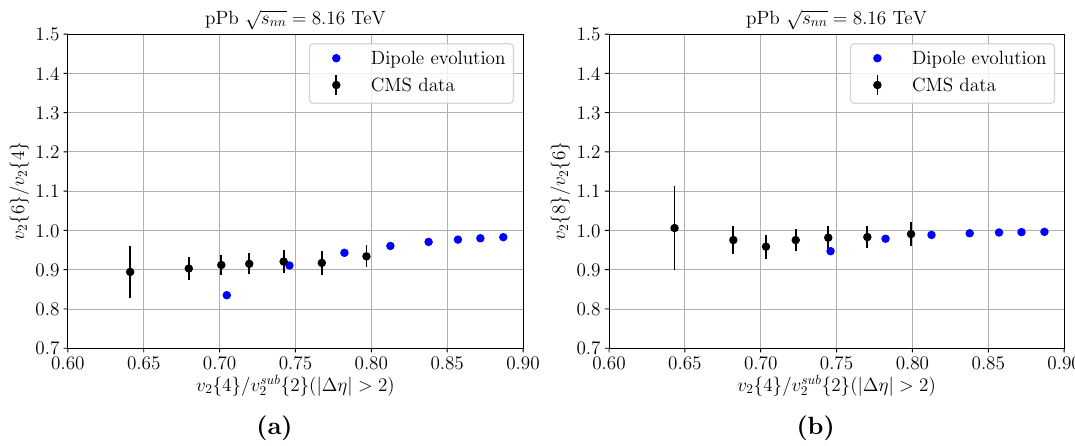
Figure 15. Correlations between higher order (cid:13)ow harmonics as measured by the CMS experiment, compared to correlations between higher order eccentricity ratios calculated in the dipole